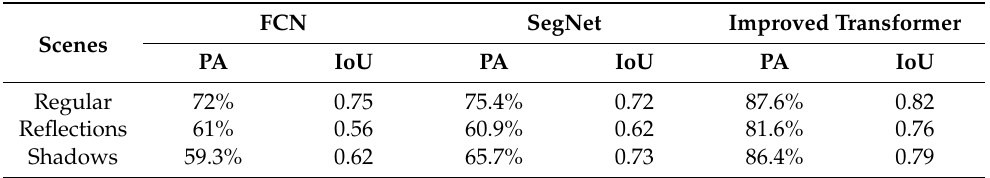
Table 4. Comparison of the detection performance of different deep-learning methods for cyanobacterial blooms in various scenarios.